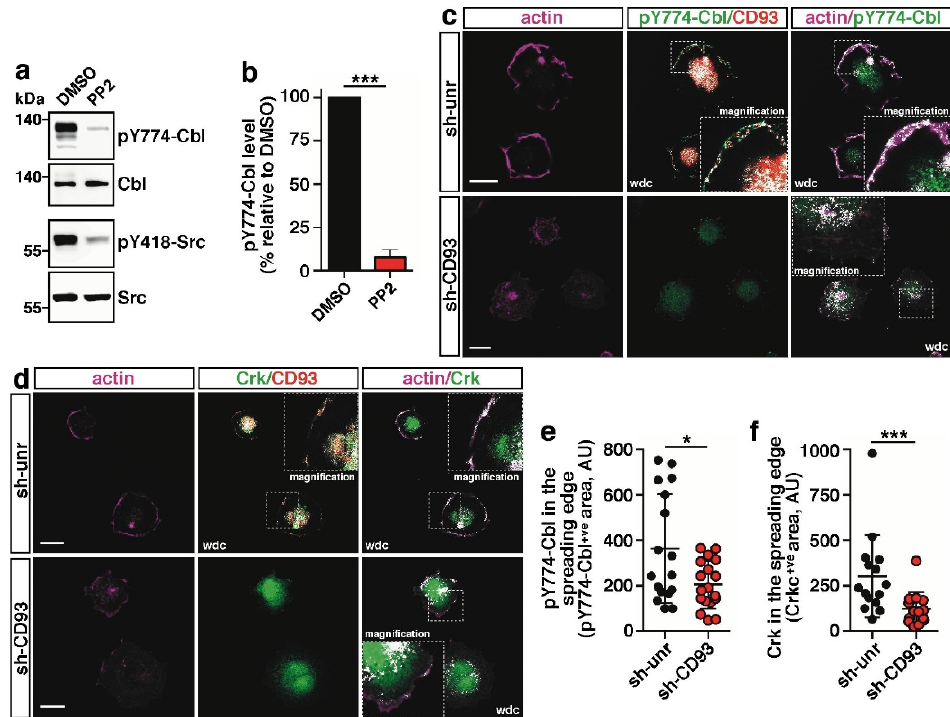
Figure 2. CD93 triggers the pY774-Cbl-dependent signaling pathway in spreading ECs. ( a ) Cell lysates from early spreading HUVECs pretreated for 30 min with vehicle alone (DMSO) or 10 µ M PP2 were analyzed by Western blotting using antibodies against pY774-Cbl and pY418-Src to confirm PP2 activity. Equal loading was confirmed by using anti-Cbl and anti-Src antibodies. ( b ) Quantification of pY774-Cbl phosphorylation levels from independent experiments performed as in ( a ). Values, normalized to Cbl protein levels, represent the percentage of pY774-Cbl levels relative to vehicle-treated cells (DMSO). *** p < 0.001; paired t -test. ( c , d ) HUVECs were transduced with lentiviral particles expressing unrelated (sh-unr) or CD93 shRNA (sh-CD93). Cells were detached from the plate, resuspended in complete growth medium, plated on the substrate, and fixed at early phases of spreading. Cells were analyzed by immunofluorescence using phalloidin, anti-CD93 antibody, and antibodies against pY774-Cbl ( c ) and Crk ( d ). White dot colocalization (wdc) images are shown as indicated. In the wdc pictures, magnification of the squared areas is shown (2.5 × ). Scale bars, 20 µ m. ( e , f ) Quantification of cellular pY774-Cbl ( e ) and Crk ( f ) in the spreading border area (5 µ m from the cell edge) of HUVECs transduced and treated as in ( c ) ( n = 14 cells for sh-unr and n = 16 cells for sh-CD93) and ( d ) ( n = 15 cells for sh-unr and n = 14 cells for sh-CD93). Data are presented as scatter plots and the fluorescence intensity of the pY774-Cbl +ve and Crk +ve signals per area is reported as arbitrary units (AU). * p < 0.05; Student t -test ( e ). *** p < 0.001; Mann–Whitney test ( f